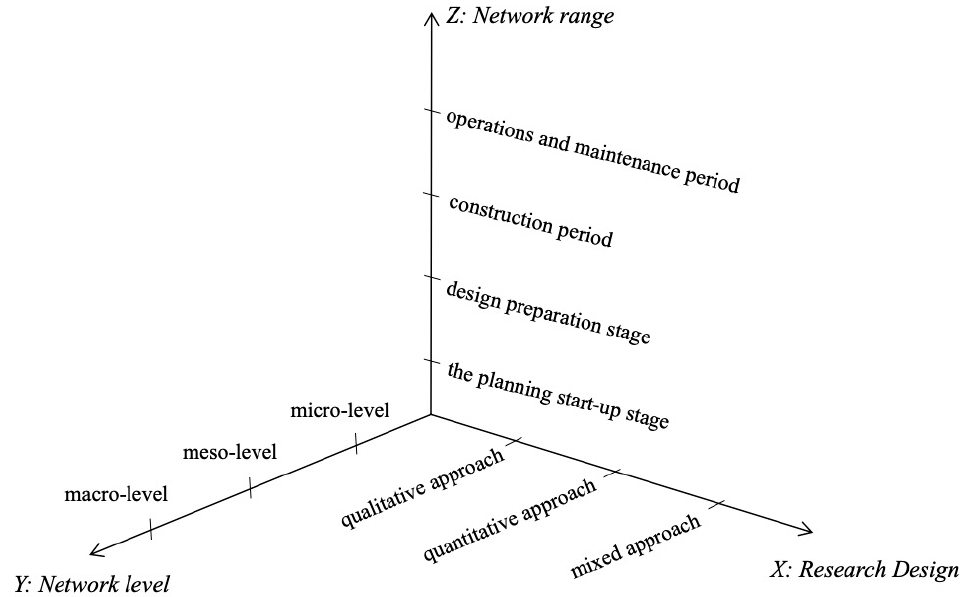
Figure 2. Multiple dimensions in network research for construction projects.